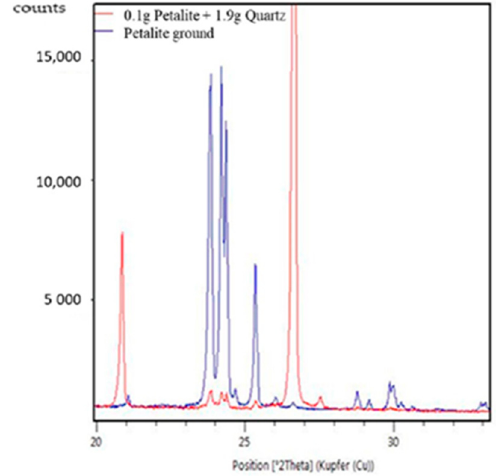
Figure 8. XRD pattern of lithium mineral, petalite (95% quartz and 5% petalite)